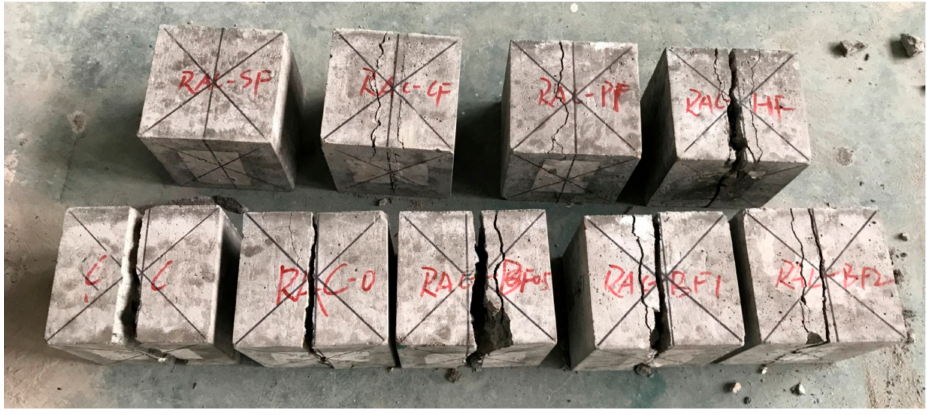
Figure 8. Failure modes of splitting tensile